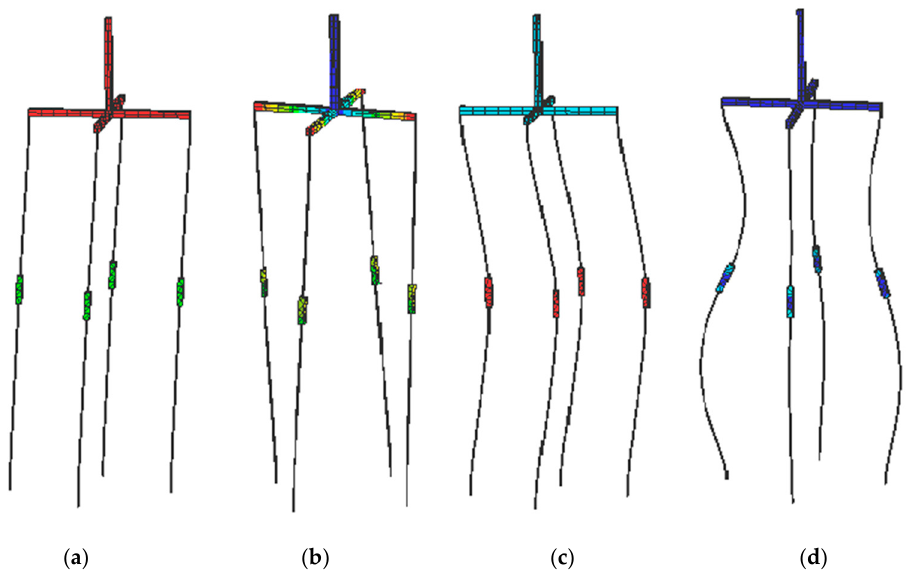
Figure 10. Mode shapes of Serbuoys-TLP. ( a ) n = 1 (Surge); ( b ) n = 3 (Yaw); ( c ) n = 9 (Tether-1h); ( d ) n = 12 (Tether-2h).